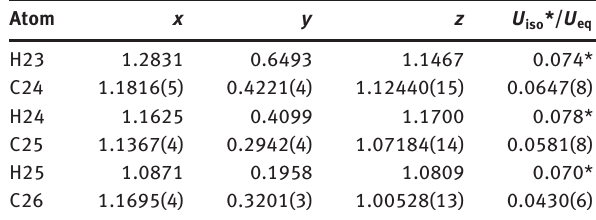
Table 2: Fractional atomic coordinates and isotropic or equivalent isotropic displacement parameters (Å 2